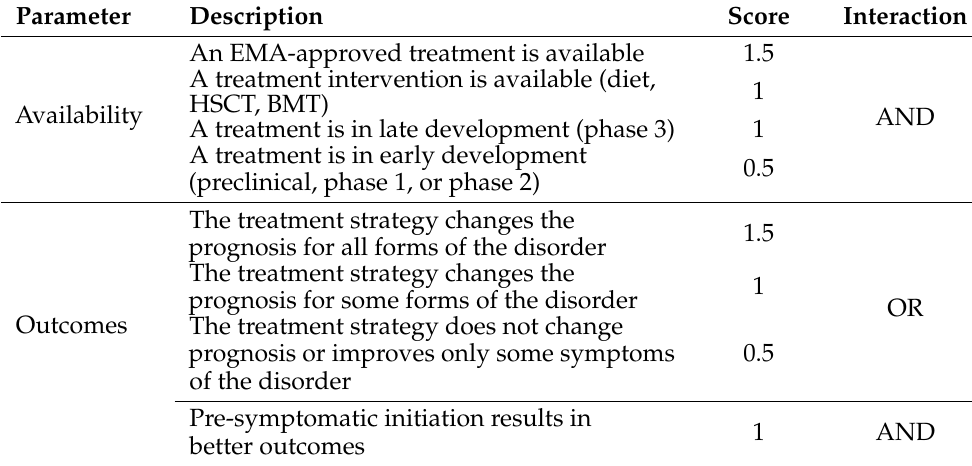
Table 5. Components of Pillar 3,